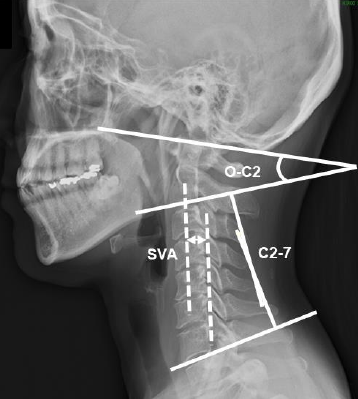
Figure 2. Measurement of cervical sagittal alignment on radiographs. SVA: C2-7 sagittal vertical axis; C2-7: cervical lordosis; O-C2: occipito-C2 lordosis.